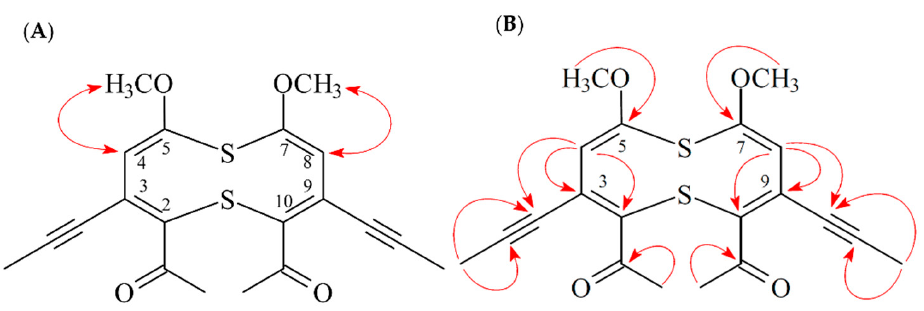
Figure 6. Key 1D-selective NOESY ( A ) and HMBC ( B ) correlations of 5 . Table 4. 1 H and 13 C NMR data of 5 .